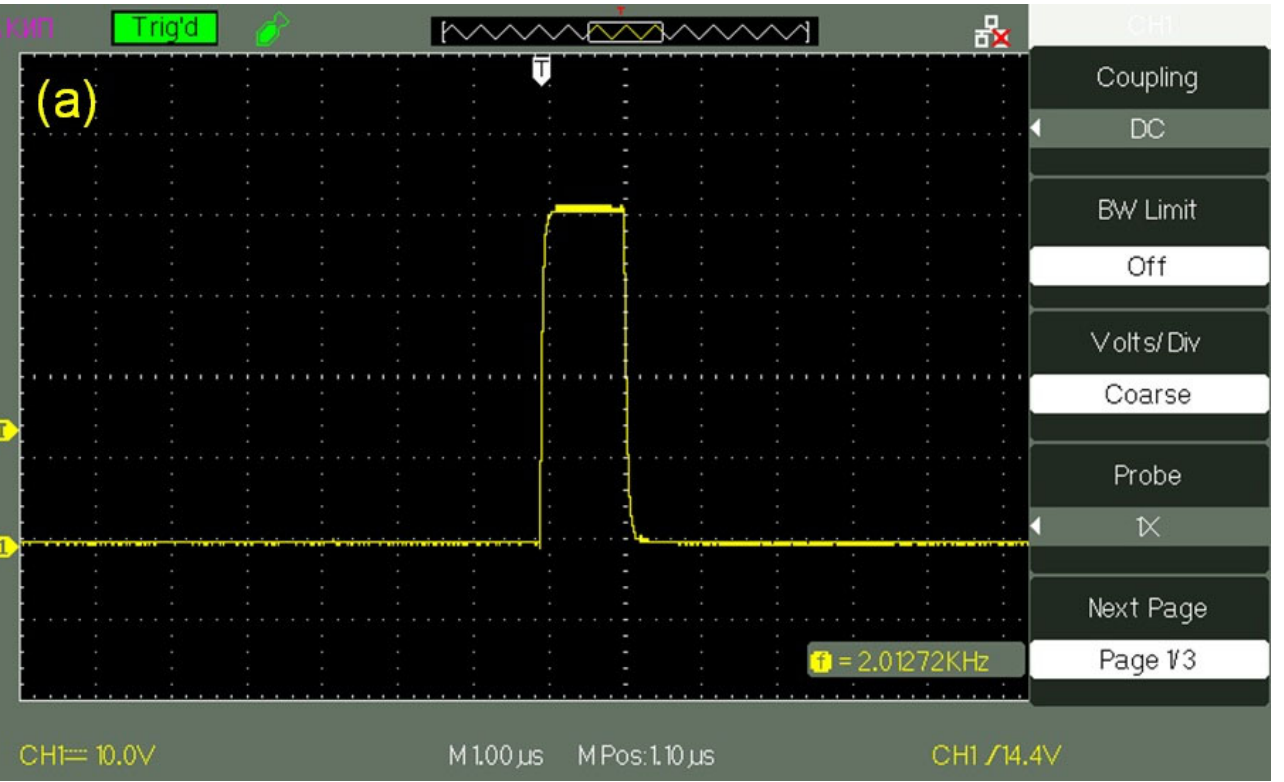
Figure 1. A schematic of the experimental setup: (1) continuous wave laser diode, (2, 5) multimode optical fibers, (3) cell with liquid sample, (4) Nafion plate, (6) spectrometer, (7) computer, (8) stage with horizontal micrometric feed for aligning Nafion plates with respect to the optical axis, and (T) is thermostat.